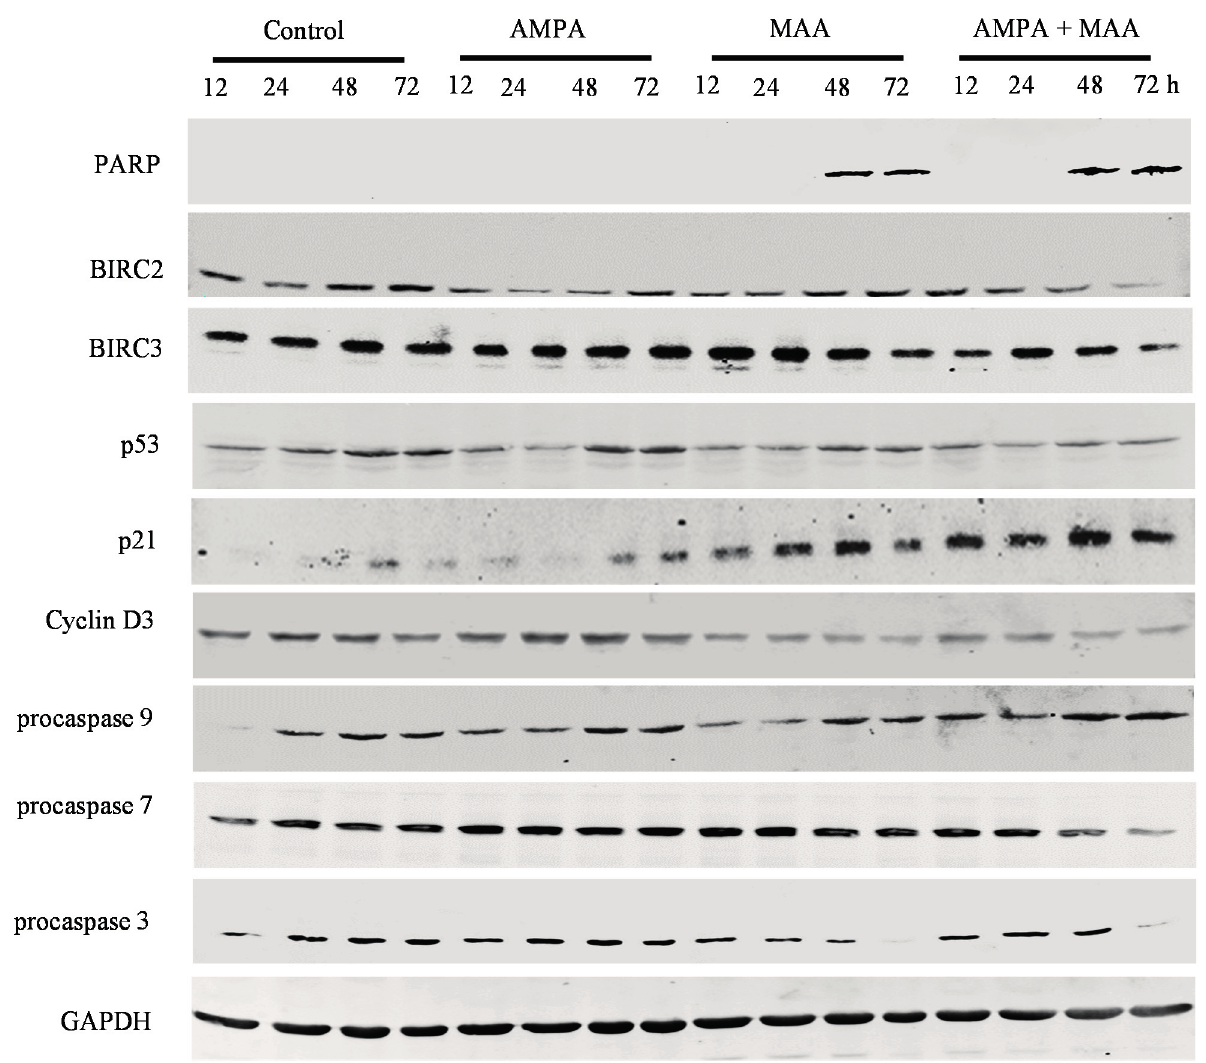
Figure 5. AMPA and MAA induce changes in the expression levels of genes involved in cell cycle arrest and apoptosis. C4-2B cells were exposed to 15 mM AMPA, 5 mM MAA or a combination of both AMPA and MAA for different time periods. The protein extracts were analyzed by Western blot to detect the indicated proteins. GAPDH was probed as the loading